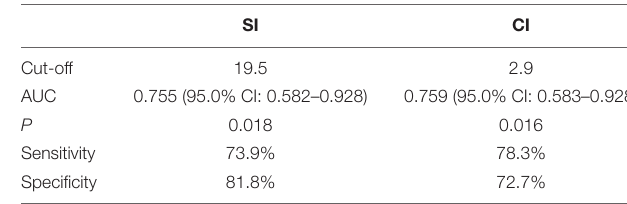
TABLE 5 | Value of SI and CI in predicting septic shock related-death or severe brain